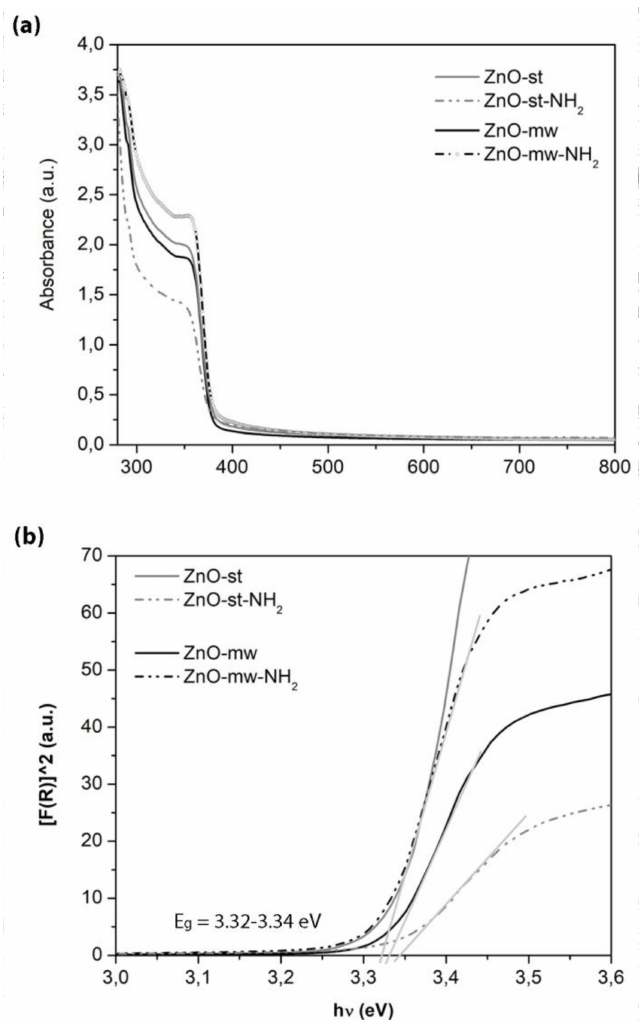
Figure 7. Characterization of the optical properties of pristine (solid lines) and functionalized (dashed lines) ZnO NCs obtained with the two preparation methods (conventional, in grey vs. microwave, in black). ( a ) Ultraviolet–visible (UV − vis) absorption spectra and ( b ) optical band gap